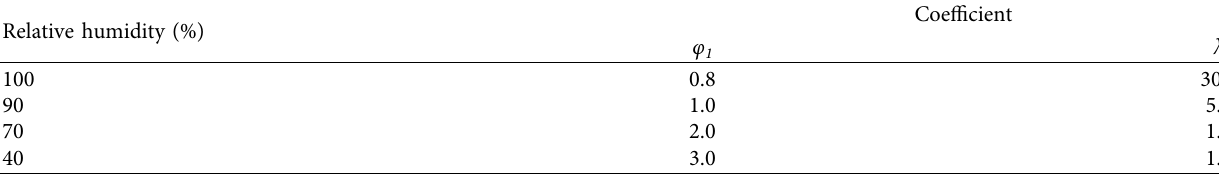
Table 3: Creep coefficient.